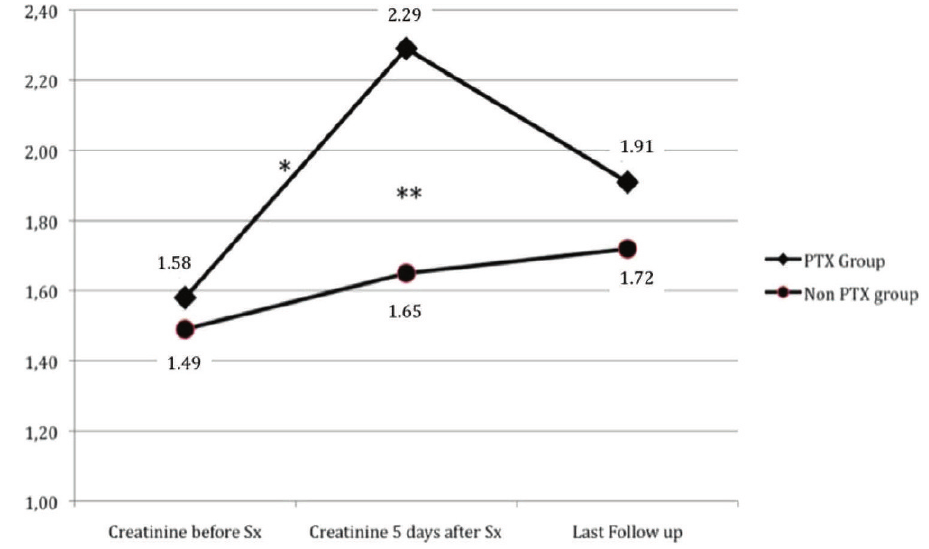
Figure 2 - Renal Function before surgery, after surgery and at the last follow